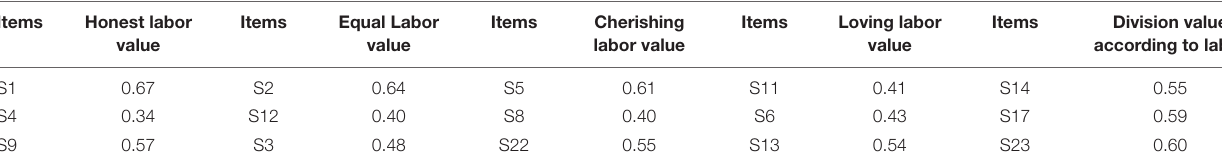
TABLE 1 | Factor normalized load estimation results basing on exploratory factor analysis.